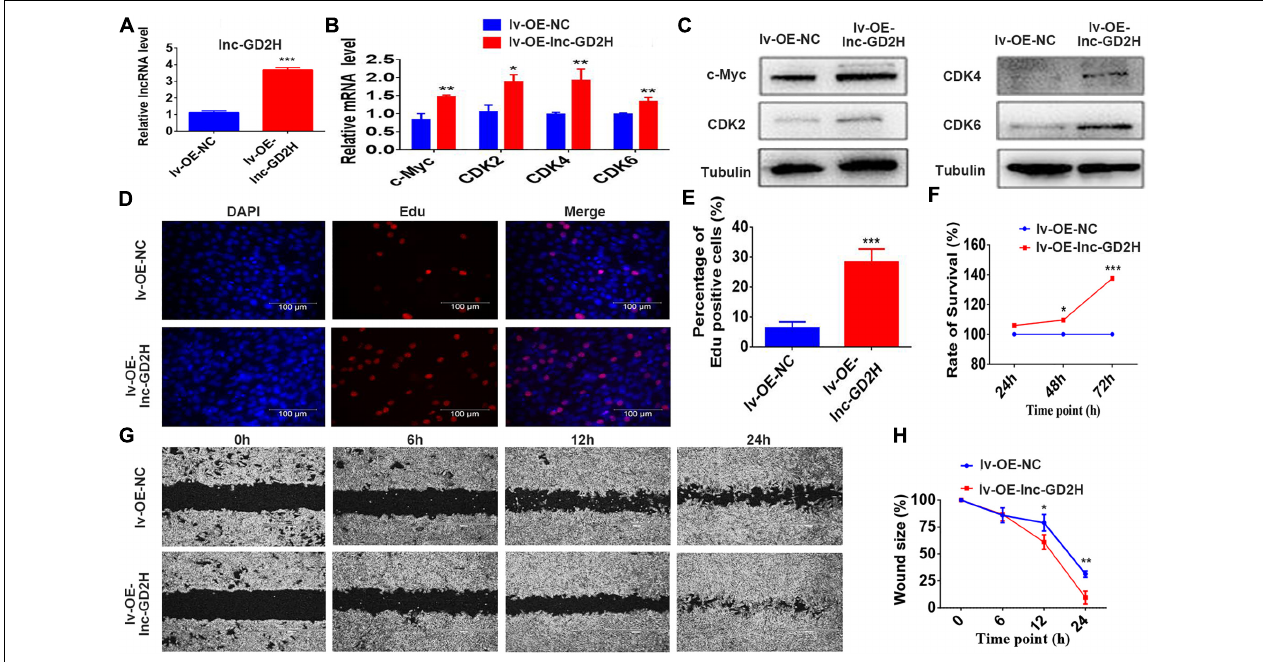
FIGURE 2 | Overexpression of lnc-GD2H promoted proliferation and enhanced c-Myc expression. (A) lnc-GD2H relative expression level in lnc-GD2H-overexpressing C2C12 myoblasts infected with lentivirus. (B,C) Expression levels of the proliferation marker genes c-Myc, CDK2, CDK4, and CDK6 in lnc-GD2H-overexpressing myoblasts were quantified using qPCR and western blotting. (D) Analysis of cell proliferation using an EdU assay in lnc-GD2H-overexpressing myoblasts. (E) Percentage of EdU-positive cells in lnc-GD2H-overexpressing myoblasts. (F) Cell survival was analyzed using the CCK-8 assay in lnc-GD2H-overexpressing myoblasts. (G) Wound healing assay of lnc-GD2H-overexpressing myoblasts. (H) Percentage wound size after scraching was shown in lnc-GD2H-overexpressing myoblasts. n = 3, * P < 0.05, ** P < 0.01, and *** P <